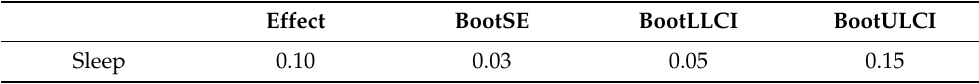
Table 6. Indirect effect of the safe haven support from the mother (SHS_M) on sleep